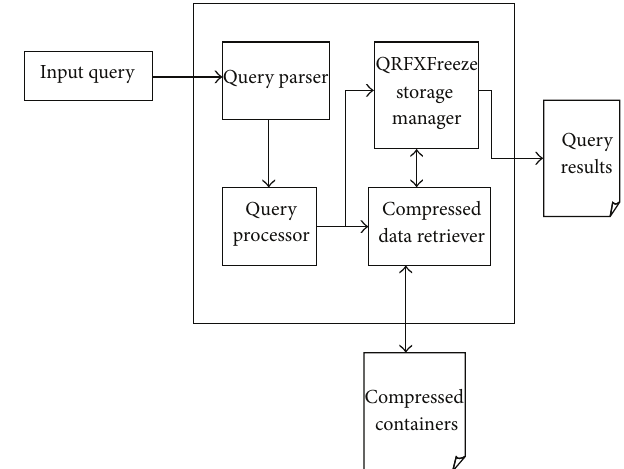
Figure 4: Architecture of QRFXFreeze query